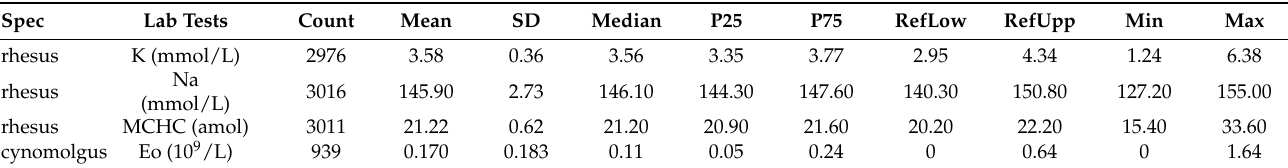
Table 9. Combined reference intervals for age and gender.